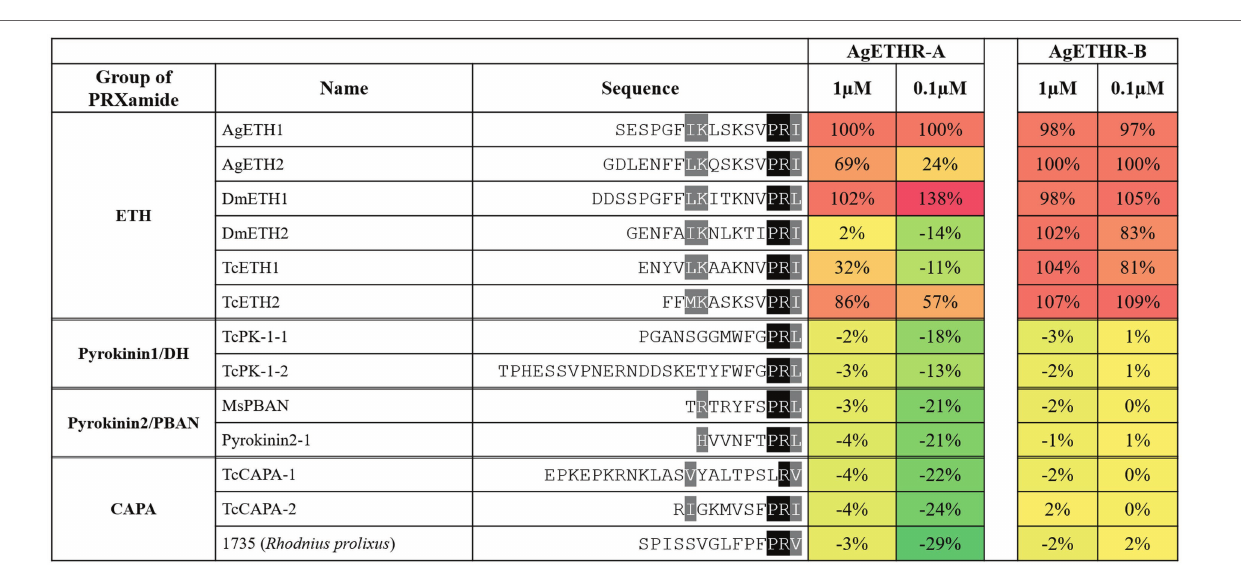
FIGURE 4 | Agonistic activities of the group of PRXamide on AgETHR-A and AgETHR-B. Two concentrations of each neuropeptide were tested on both AgETHR-A and AgETHR-B. The value was normalized by the activity of AgETH1 for AgETHR-A and AgETH2 for AgETHR-B, respectively. The conserved sequences were highlighted in black and